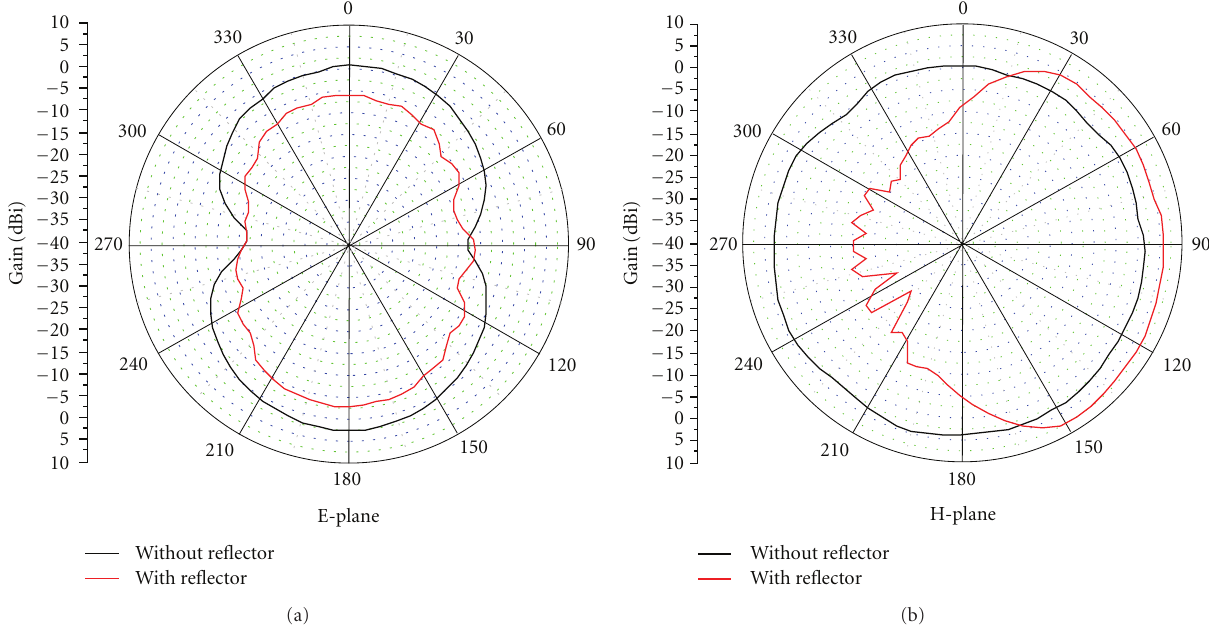
Figure 13: Experimental radiation diagrams of dipole with and without reflector at